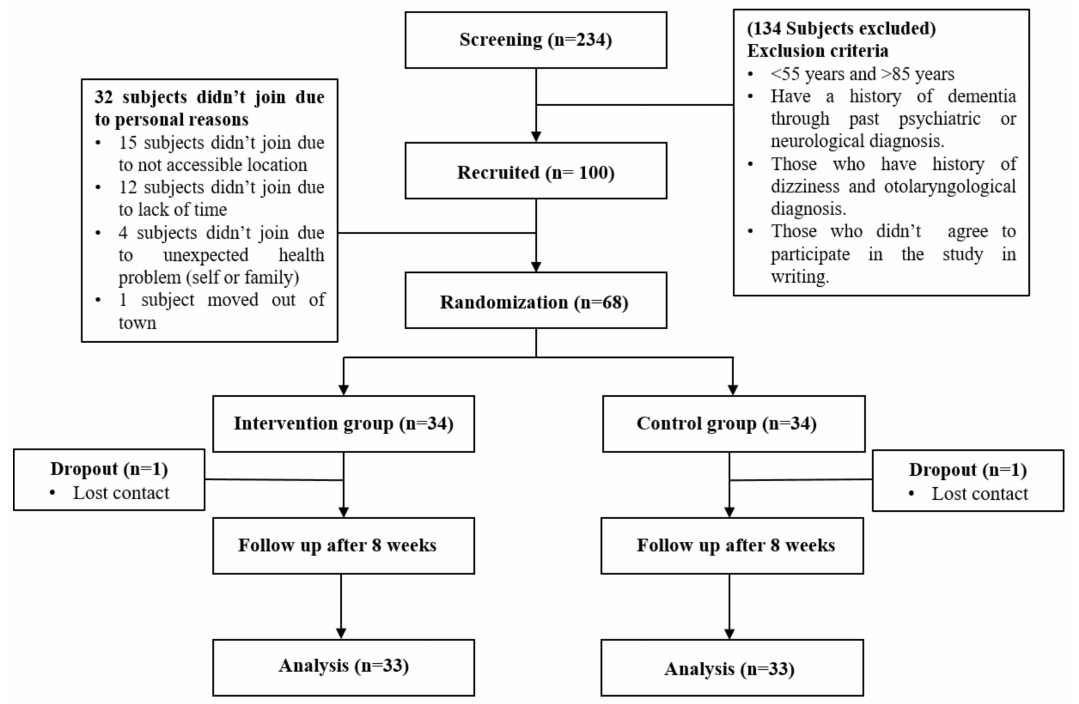
Figure 1. Flowchart of study